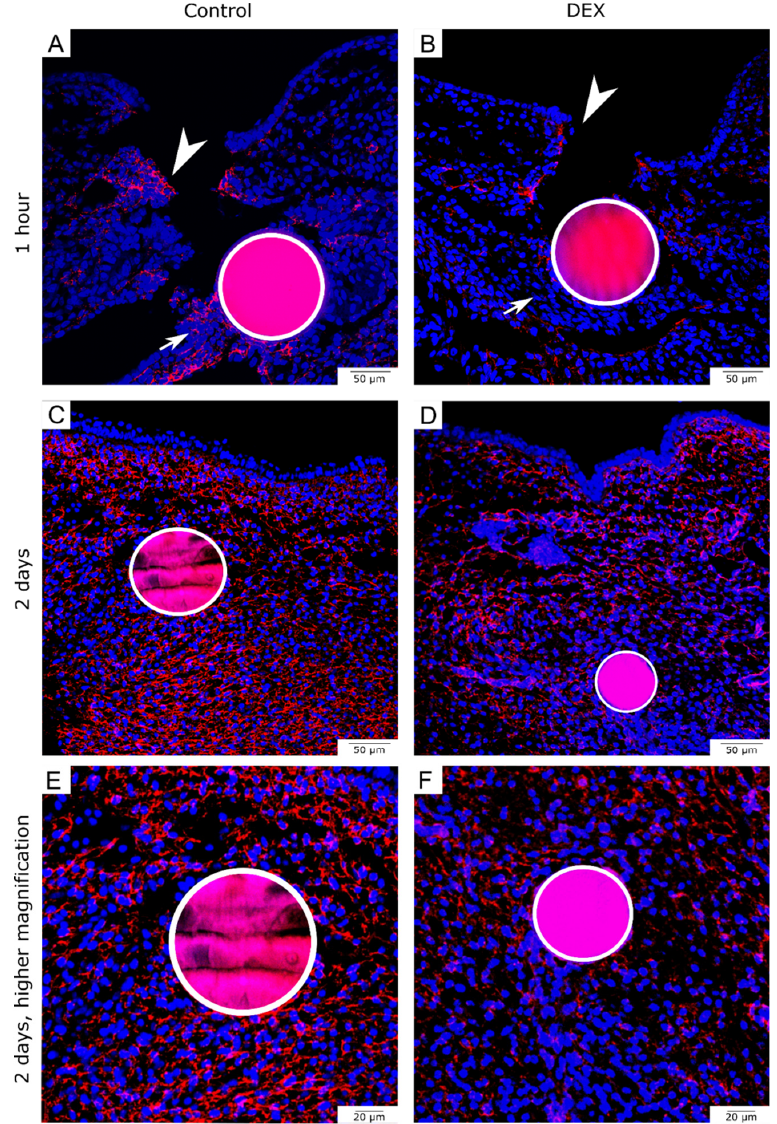
Figure 4. Fibronectin expression in bead-implanted wounds. The images show immunohistochem- istry for fibronectin in the bead-implanted wounds. ( A ) shows a control wound after one hour. ( B ) shows a dex wound after one hour. Note the reduced expression of fibronectin at the wound mar- gins (white arrowheads in ( A , B )) and in the tissue surrounding the bead (white arrow in ( A , B )). ( C ) shows a control wound after two days. Note, that Fibronectin is found directly adjacent to the bead. ( D ) shows a dex wound after two days. ( E , F ) show the same sections in higher magnification re- spectively. Note the disturbed matrix pattern of fibronectin in dex wounds after two days, as well as a downregulation of fibronectin expression in the bead area.